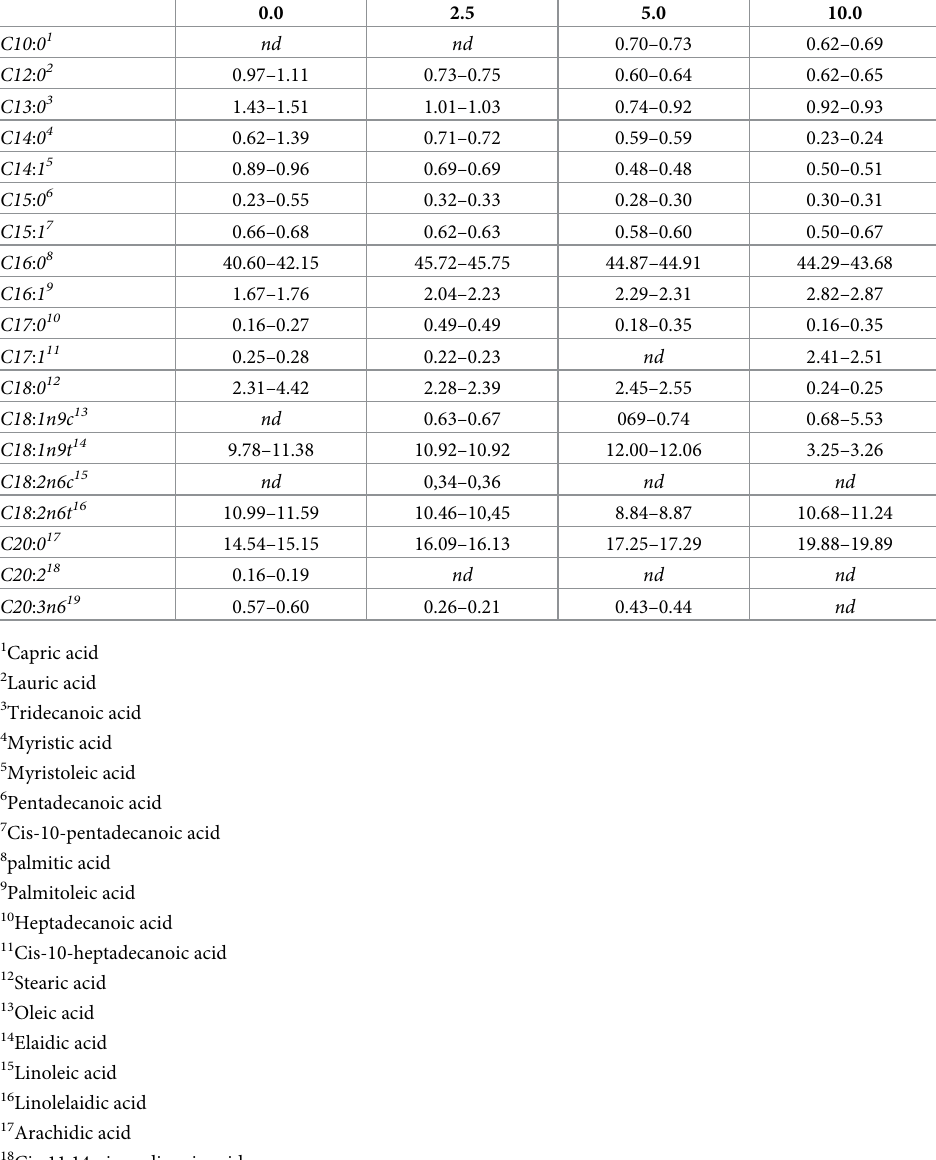
Table 4. The fatty acid methyl ester (FAME) profiles (percentage of total FAMEs) present in S . platensis biomass cultured in autotrophic medium and mixotrophic medium with the addition of buffalo mozzarella cheese